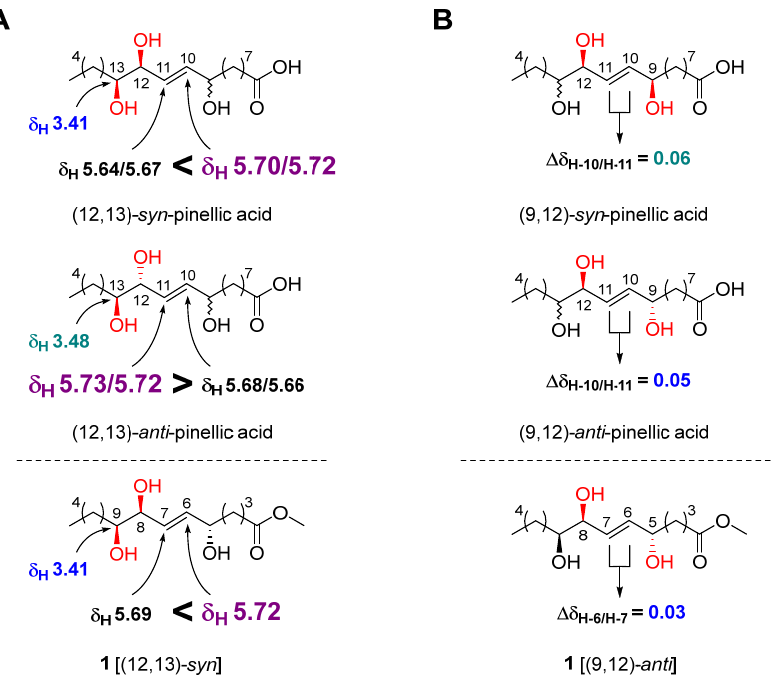
Figure 3. Relative stereochemical assignment of 1 at C-12/C-13 ( A ) and C-9/C-12 ( B ).